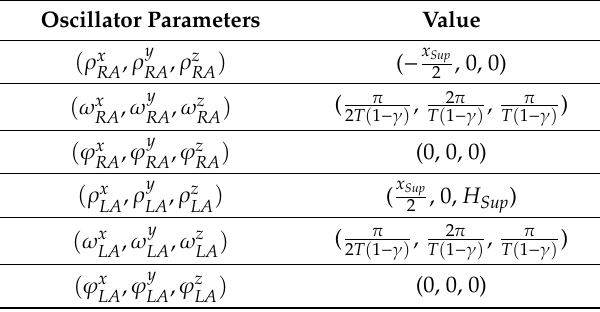
Table 2. The oscillator parameters of the stepping gait in the forward and backward balance strategies. Oscillator